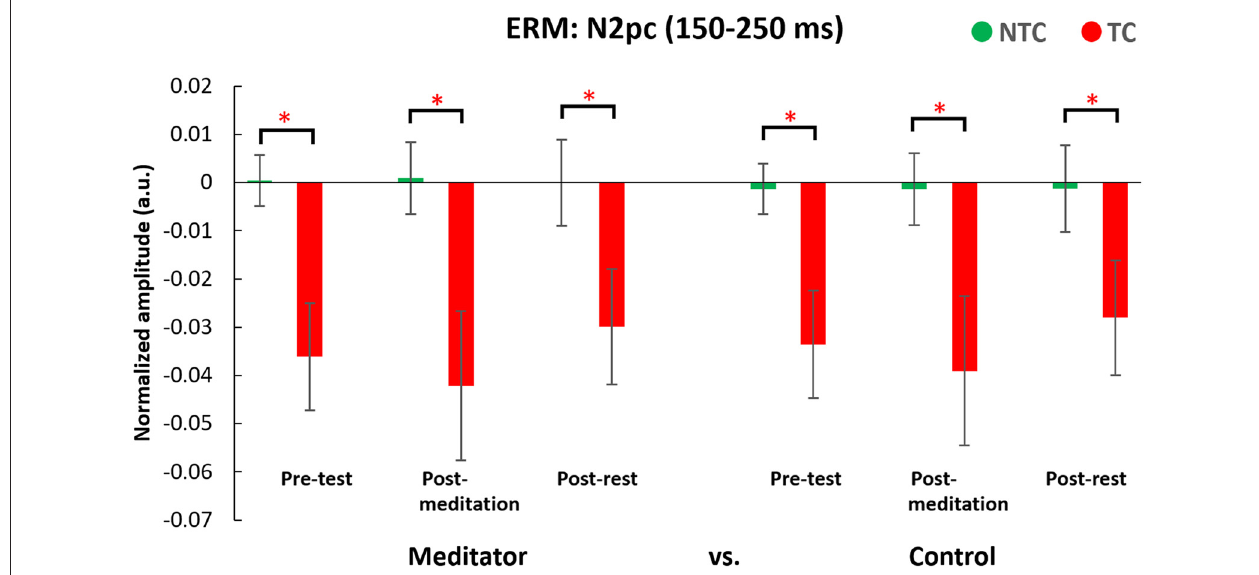
FIGURE 9 | Result for the N2pc component ERM analyses. N2pc values were significantly smaller in the TC condition than the NTC condition. Waveforms were derived from the differences between contralateral and ipsilateral waveforms. Error bars indicate 95% confidence intervals. The asterisks ( ∗ ) indicate statistically significance differences ( p < 0.05).